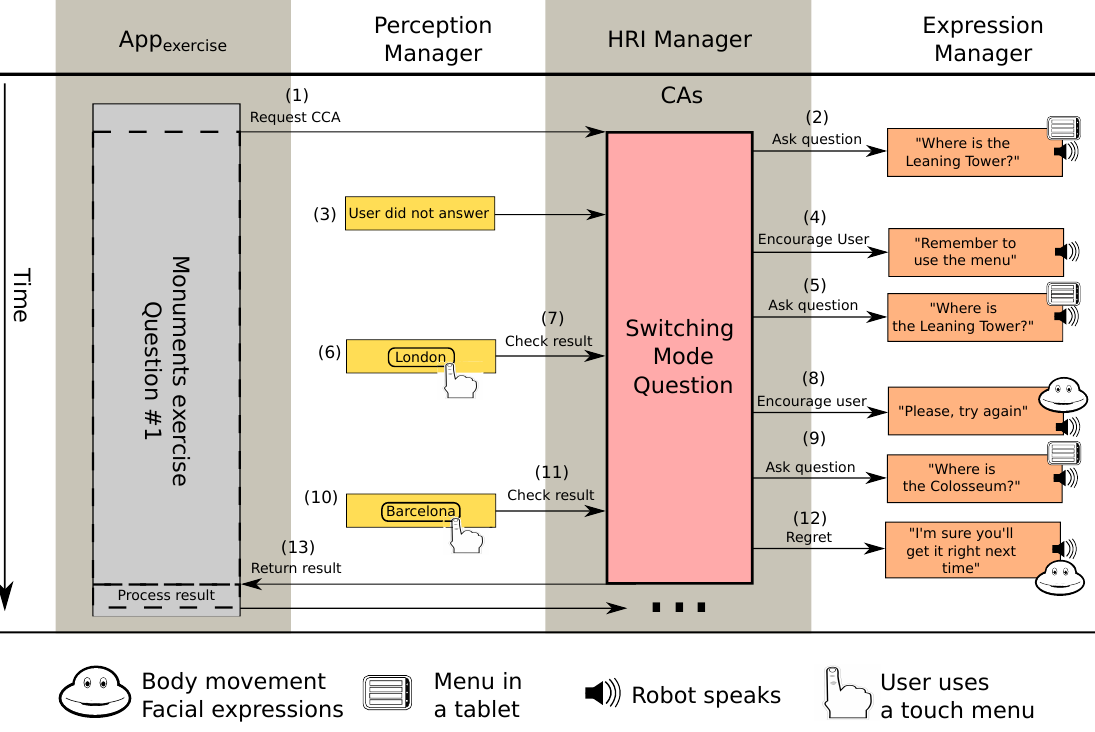
Figure 10. First question of the monuments exercise. The boxes represent actions performed by the different agents and the arrows represent the connections between these actions. Numbers will be referenced in the text to help the